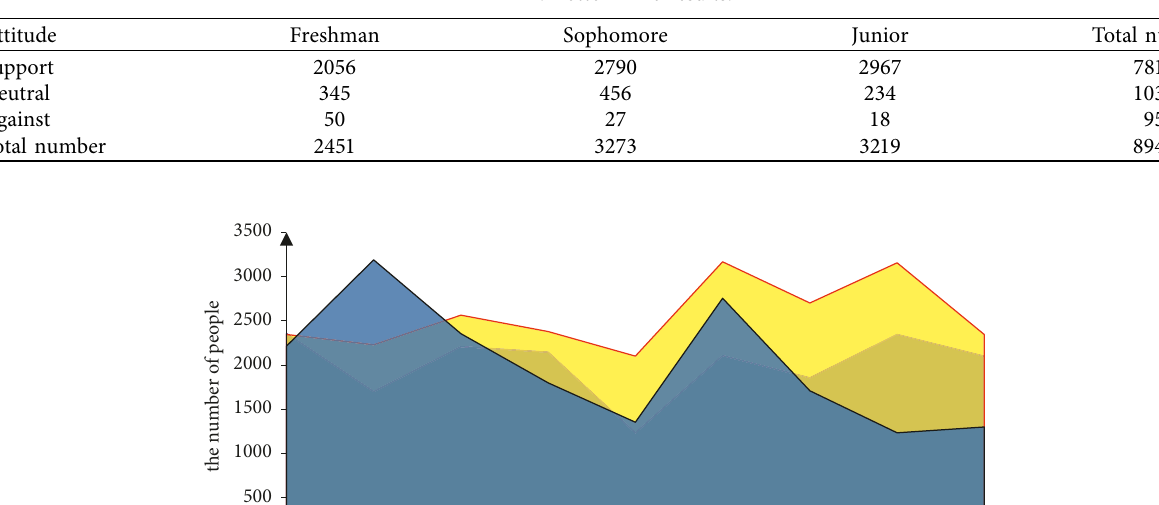
Table 1: Bottom line results.